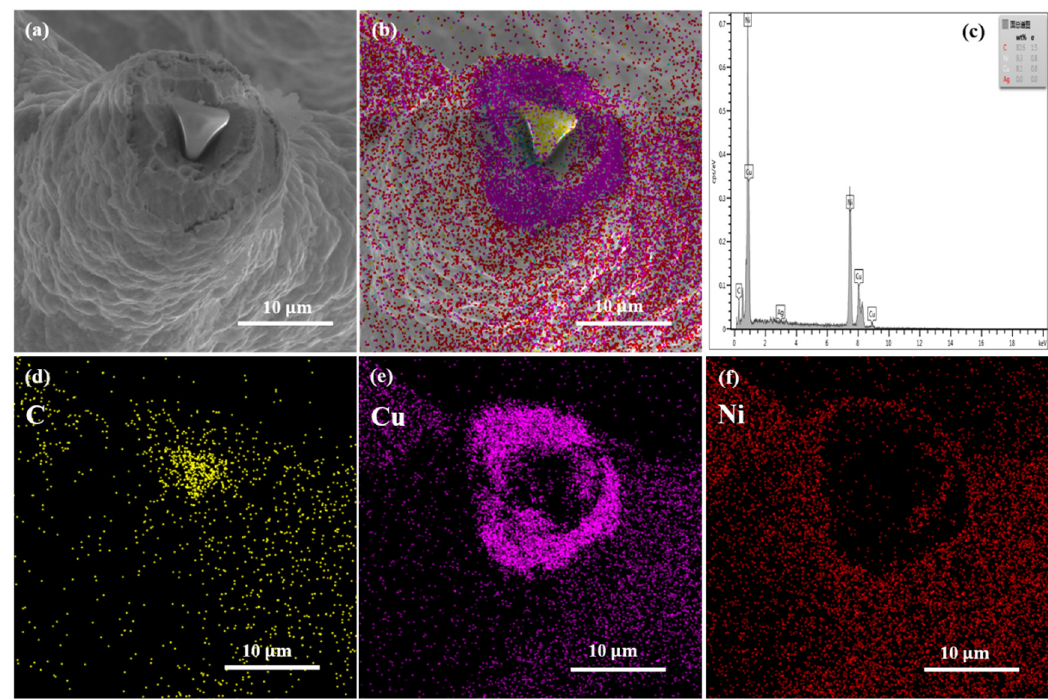
Figure 3. The cross section of Cu-Ni/CNT foams before heat treatment; ( a ) SEM observation; ( b – f ) EDS analysis of the cross section.